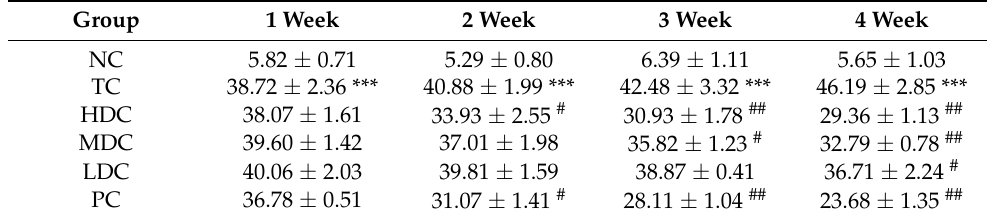
Table 2. Water intake of mice in each group